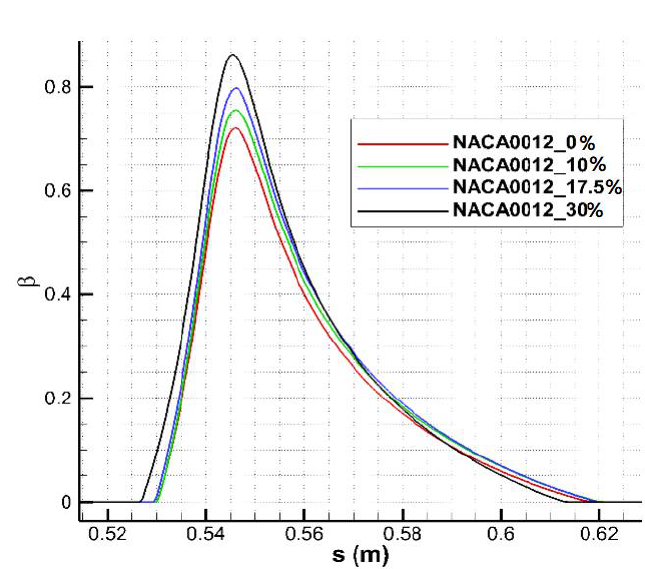
Figure 7. Droplet collection coefficients at different blockages of NACA0012 airfoil.